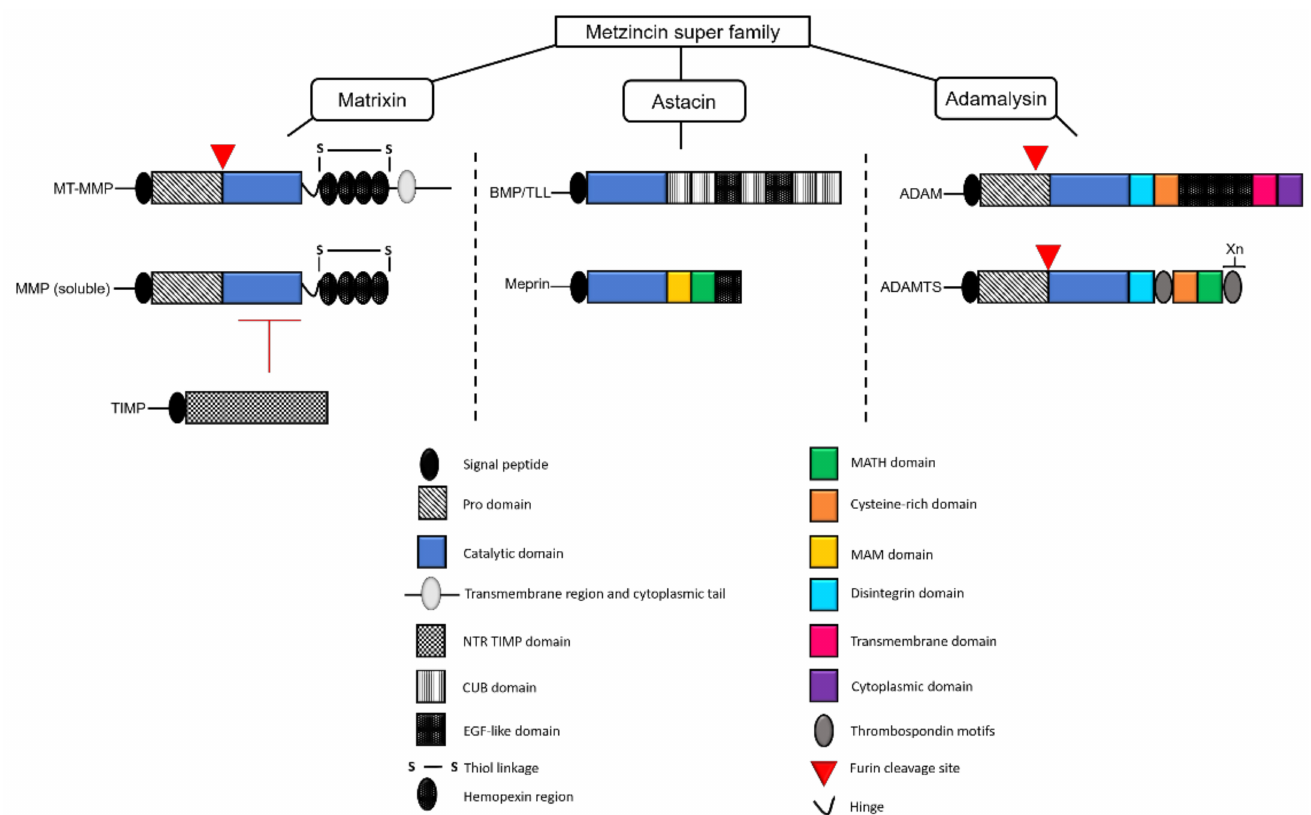
Figure 1. Structure of the metzincin superfamily members found in humans and their key regulators. Schematic representa- tion of the structural components of the metzincin subgroups found in humans, grouped by family, along with the Tissue Inhibitor of Metalloproteinases (TIMP) family of